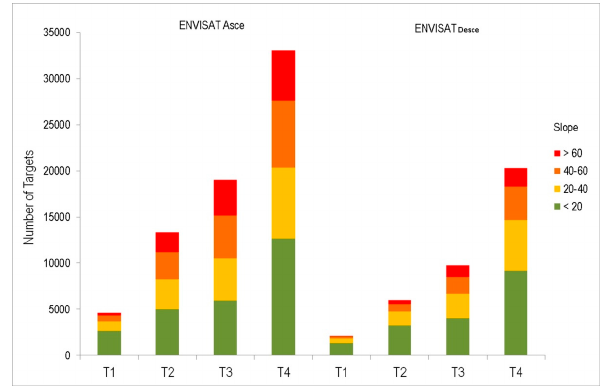
Figure 5. Graph of the number of targets of each dataset available for the Envisat satellite for each task processed. The targets are subdivided and classified with respect four slope classes, based on the slope calculation of the VDA region.